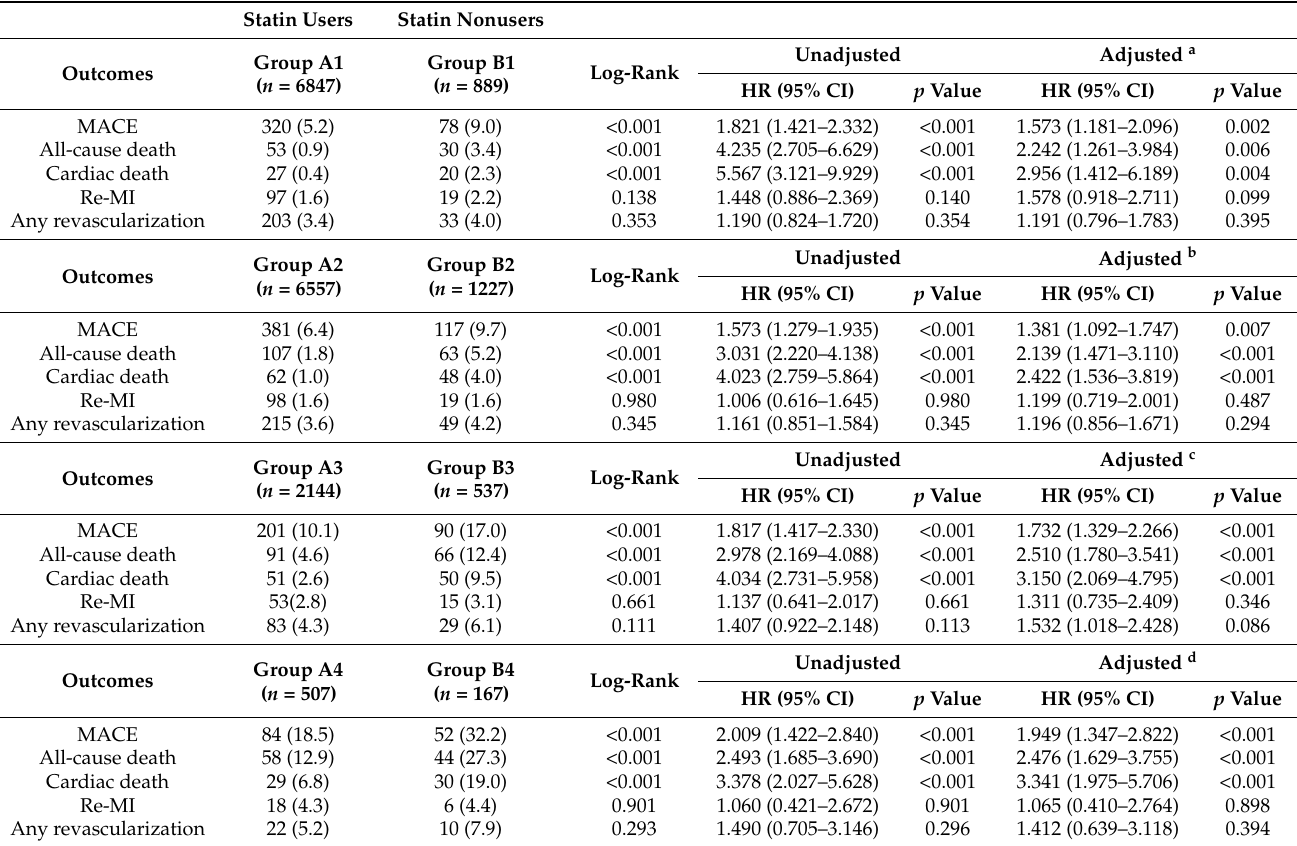
Table 6. Clinical outcomes between statin users and nonusers at 2 years.